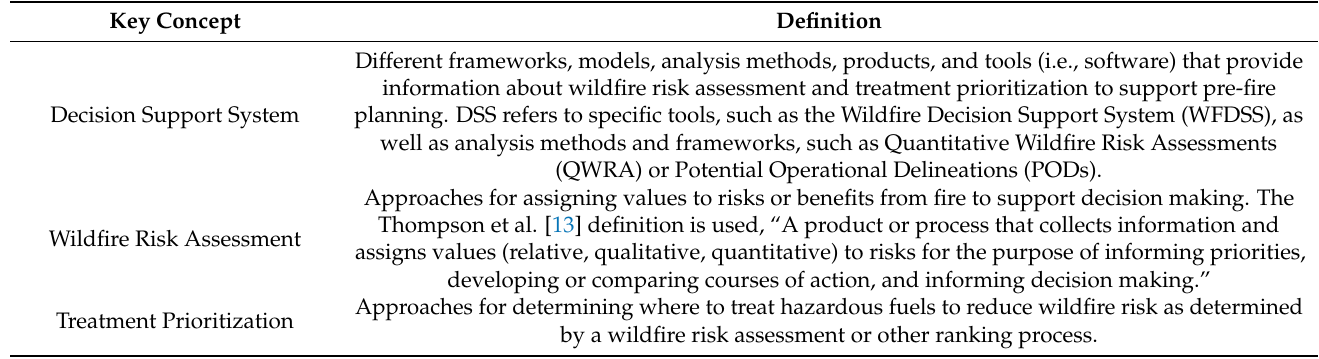
Table 1. Key concepts and their associated definitions as used in this